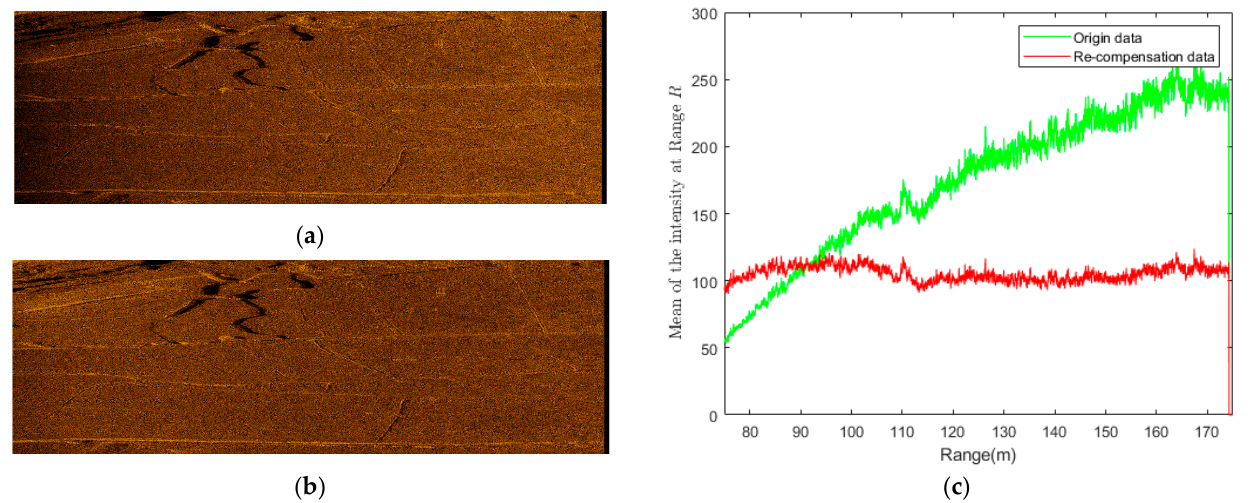
Figure 2. Comparison of a sonar image with and without time gain re-compensation. ( a ) A sonar image without time gain re-compensation. ( b ) A sonar image with time gain re-compensation. ( c ) The mean of the intensity at range R for origin data and re-compensated data.